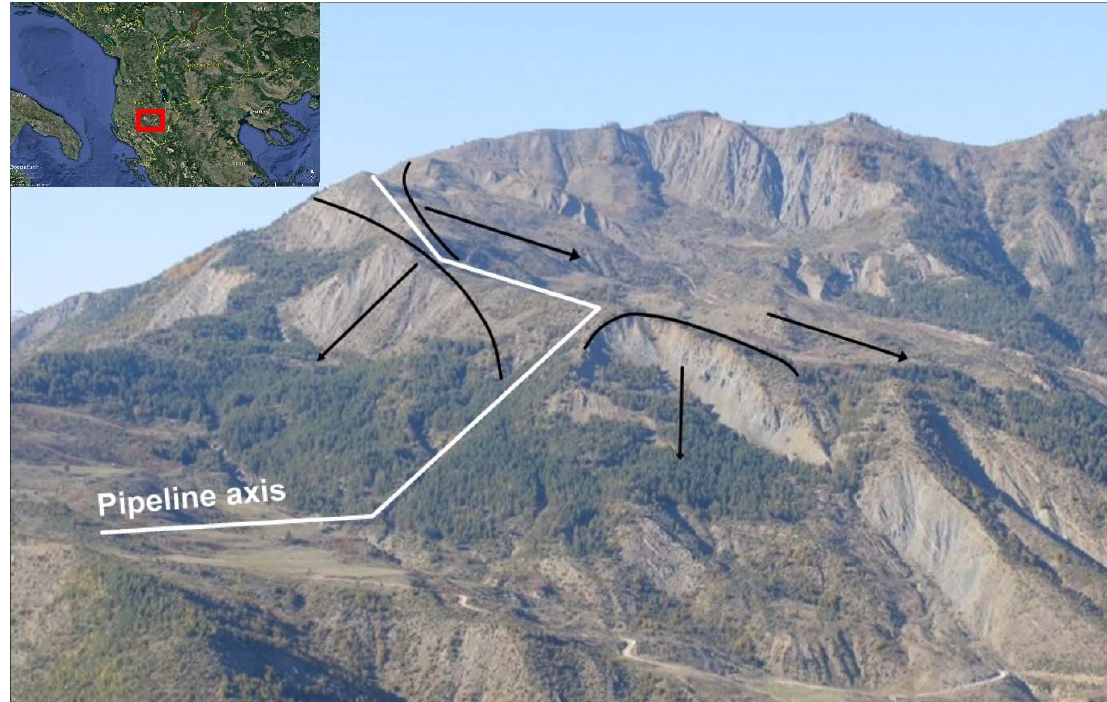
Figure 1. Pre ‐ existing landslides (black lines) along Trans Adriatic Pipeline (TAP) pipeline Right of Way (RoW) in a mountainous region of central Albania. It is evident that landsliding constitutes to be a major risk factor for pipeline integrity.